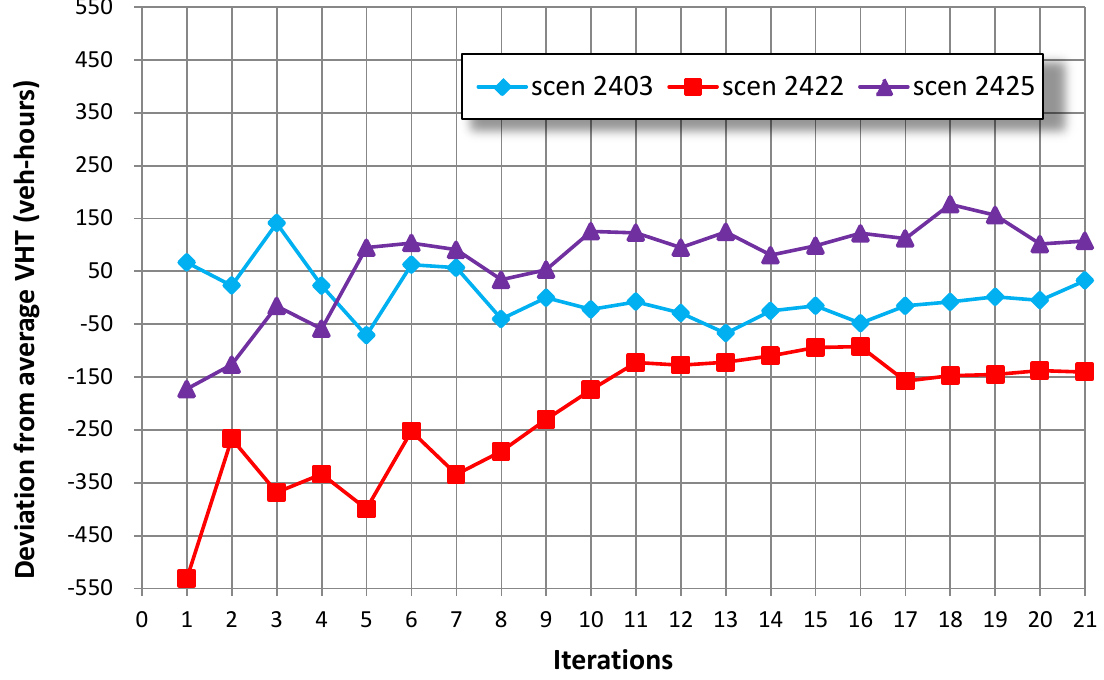
Figure 12. VHT convergence for MSA-R procedure